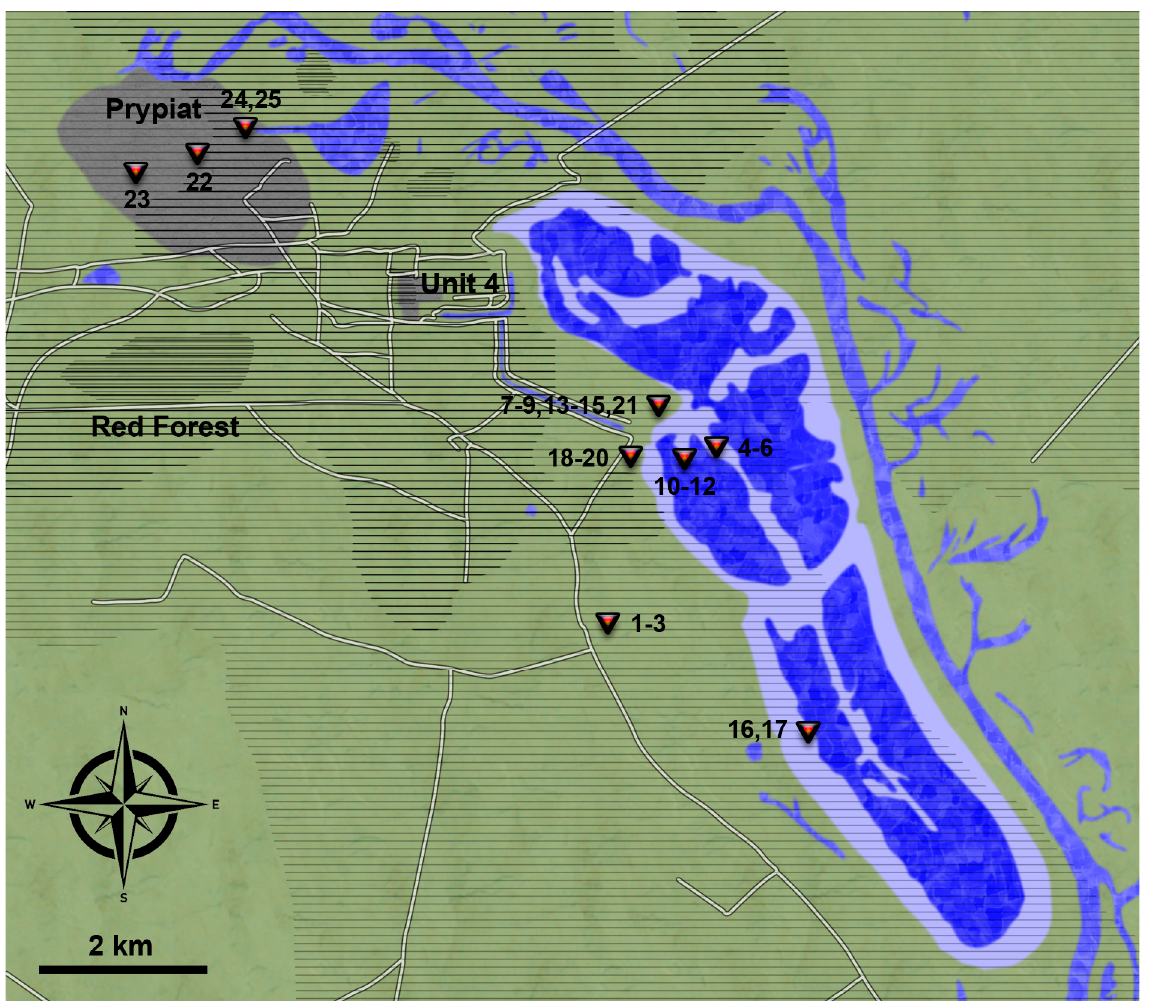
Figure 1. Map of the sampling area. Red pins indicate the sample collection points. In the cooling pond bright blue coloration indicates areas that have recently become dry and dark blue areas were still submerged in 2018. Hatches indicate deposition of 200–2000 kBq 90 Sr/m 2 , more pronounced, darker hatches 2000–20,000 kBq 90 Sr/m 2 and multiple hatches >20,000 kBq 90 Sr/m 2 . Redrawn after